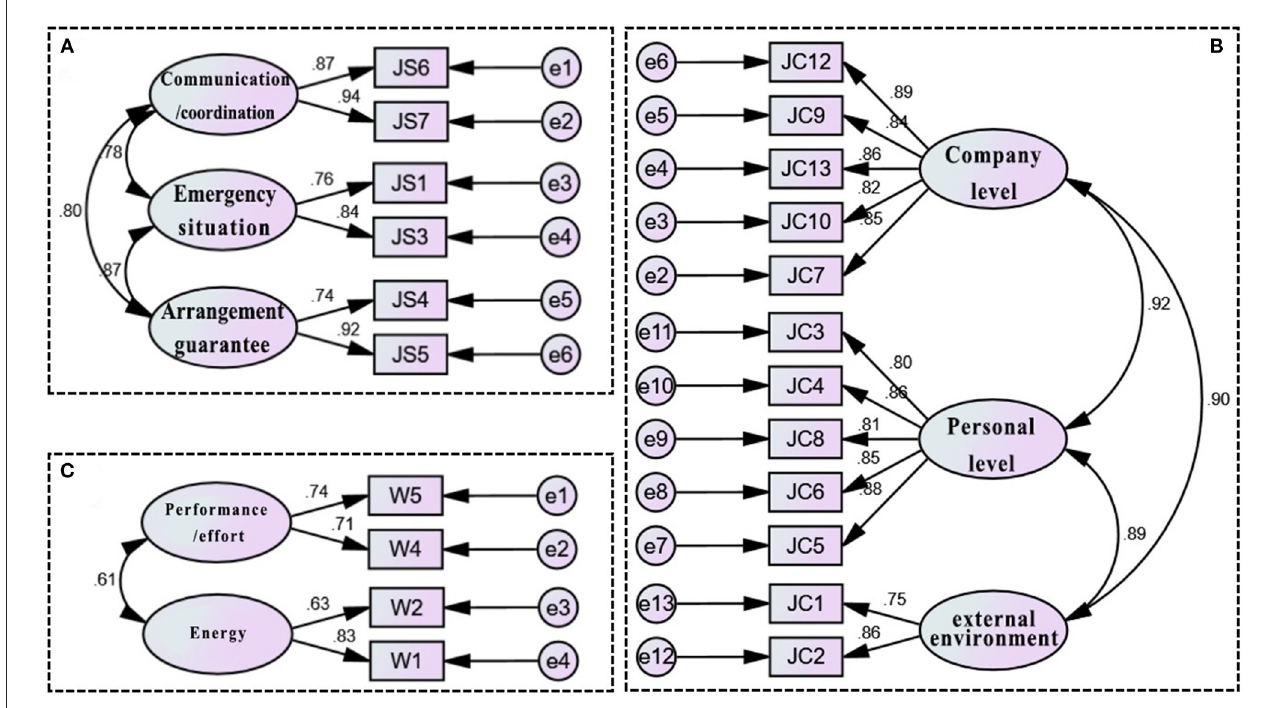
FIGURE3 CFA analysis of fatigue-influencing factors in long-haul flight pilots’ work dimension. (A) Factor of working status, (B) factor of working conditions, and (C) factor of